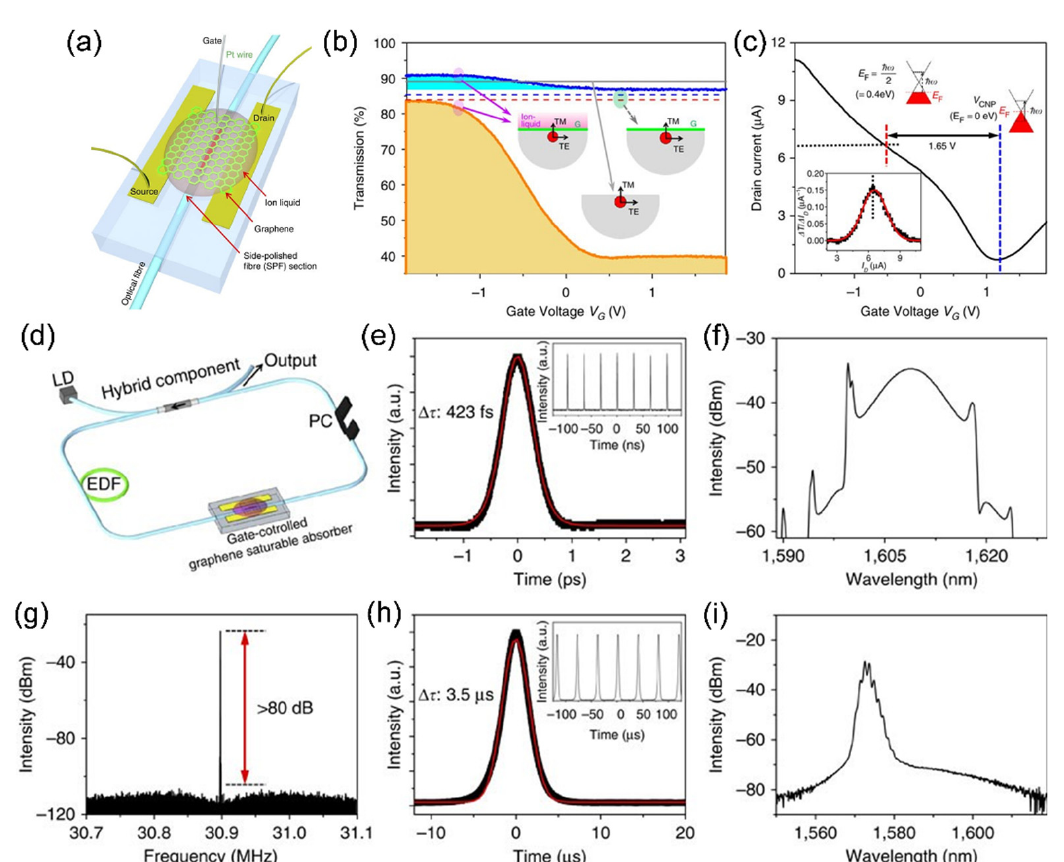
Figure 10. Electrically controlled fiber laser using an all-fiber graphene device and gate-variable properties of fiber laser operation. ( a ) Schematic diagram of gate-variable all-fiber graphene device. ( b ) Gate-controlled Optical transition properties of the device. ( c ) Gate-controlled Electrical transport properties of the device. ( d ) Fiber laser configuration, including fabricated all-fiber device with bilayer graphene. LD: laser diode; EDF: erbium-doped fiber; PC: polarization controller; hybrid component: an integrated wavelength-division multiplexer and isolator. ( e – g ) Characteristics of a passively mode-locked fiber laser at an applied V G of − 1.05 V; ( e ) Measured pulse duration of 423 fs at a repetition rate of 30.9 MHz (inset). ( f ) Laser output spectrum with a spectral bandwidth of 8 nm at 3 dB. ( g ) The measured radio frequency spectrum of the laser output ( h , i ) Q-switched characteristics of a fiber laser at an applied V G of − 0.18 V; ( h ) Measured output pulse duration of 3.5 ms at a repetition rate of 25.4 kHz (inset) and ( i ) its optical spectrum. Reproduced with permission. Copyright 2015, Springer Nature